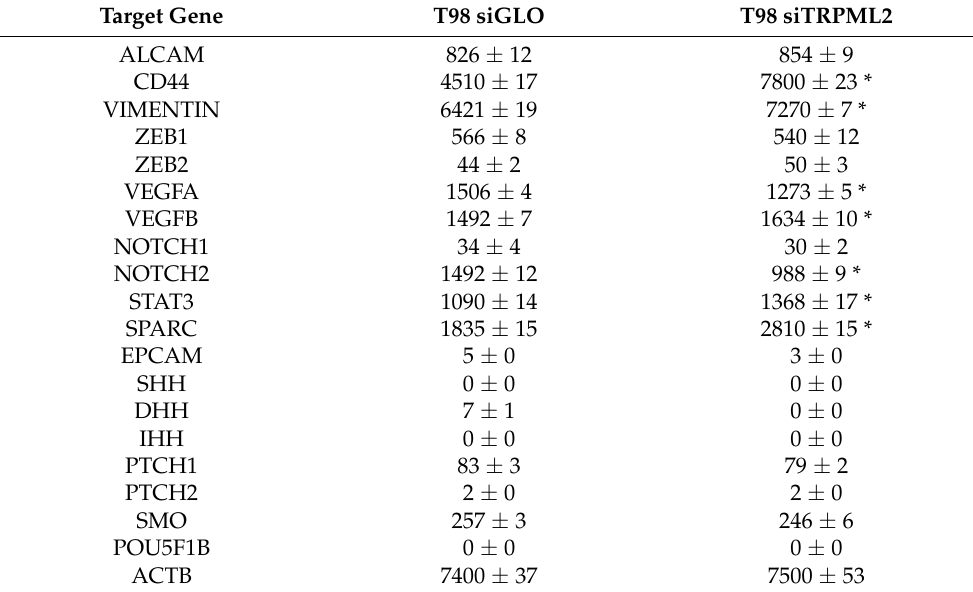
Table 1. Effects of TRPML2 silencing in the T98 cell